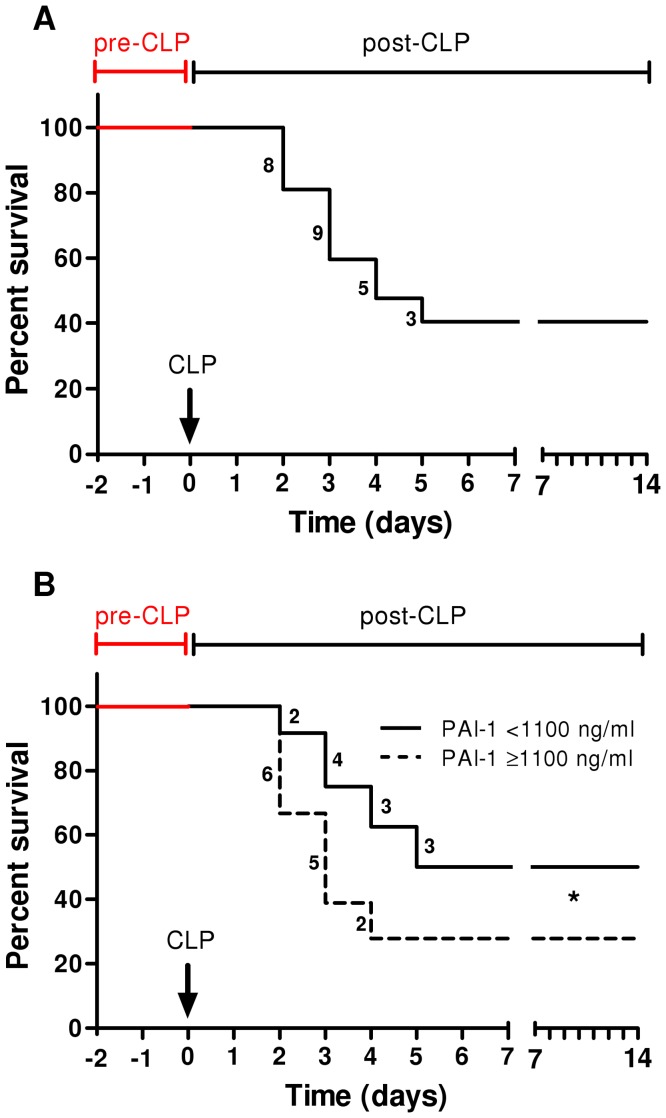
Increased plasma PAI-1 at 24 h post-TH-CLP is associated with lower 14-day survival.3 month-old mice (n = 42) were subjected to trauma and hemorrhage (TH) at −48 h followed by mild (23G) cecal ligation and puncture (CLP) sepsis at 0 h. From the TH time point on, 20 µl of blood was collected daily and additionally at 6 h, until 96 h (day 6 post-TH/day 4 post-CLP). Animals were observed until death or day 14 post-CLP, whichever occurred first. A) 14-day survival. B) Survival of mice based on plasma PAI-1 at 24 h post-CLP below or above a subjective threshold. Digits on the graph indicate the number of deaths at the indicated time point. *p<0.05 versus <1100 ng/ml. CLP time point indicated by arrow.